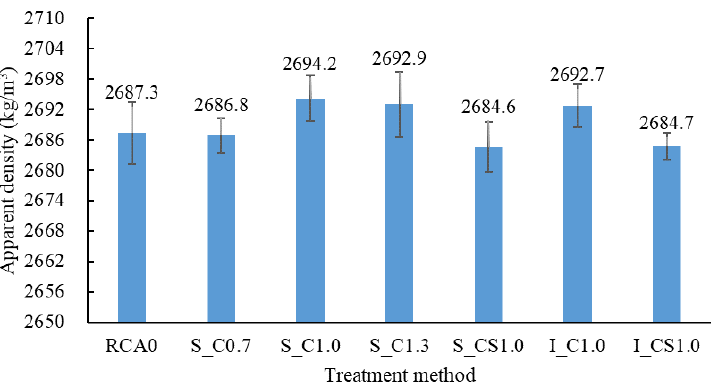
Figure 9. Apparent density of the RCA.